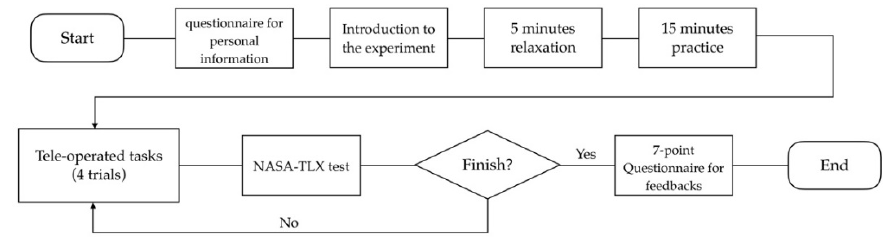
Figure 7. The procedure of the experiment.